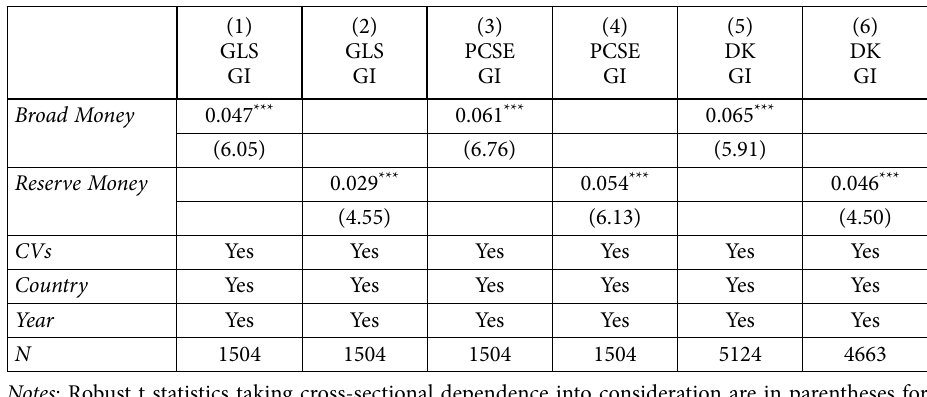
Table 6. Alternative